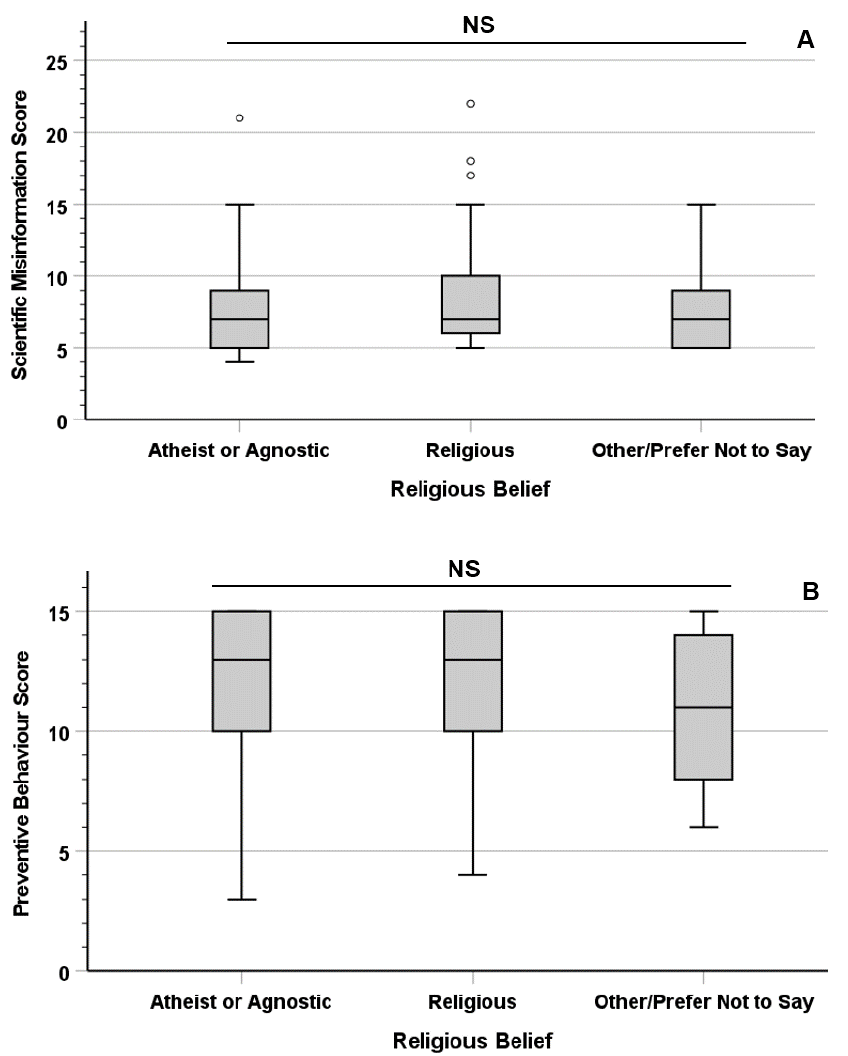
Figure 1. Association between the participants’ religious beliefs and their Scientific Misinformation Score ( A ) and Preventive Behaviour Score ( B ). Circles ( ◦ ) indicate mild